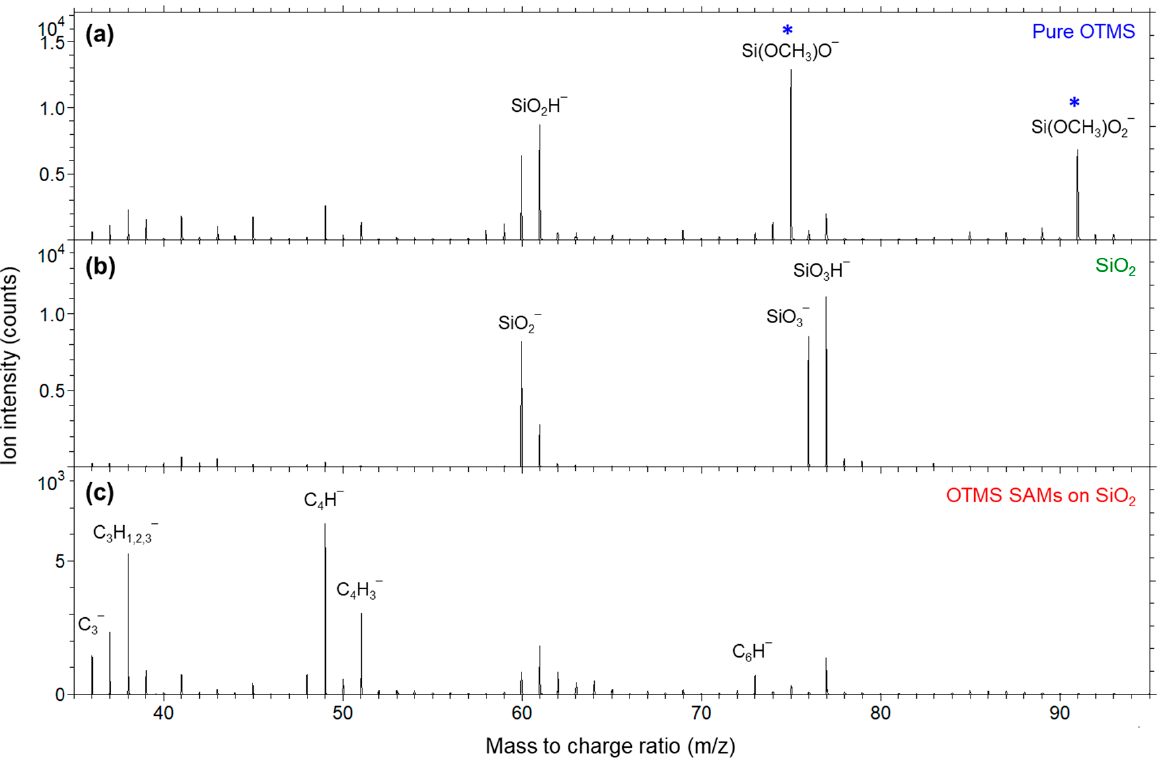
Figure 5. Negative secondary ion mass spectra ( m / z 35 ‒ 95) for ( a ) pure OTMS (placed on a polypropylene film), ( b ) a UV/ozone-treated SiO 2 substrate and ( c ) OTMS SAMs prepared on a UV/ozone-treated SiO 2 substrate. Ions indicated by a star (*) are associated with the OTMS headgroup, –Si(OCH 3 ) 3 .